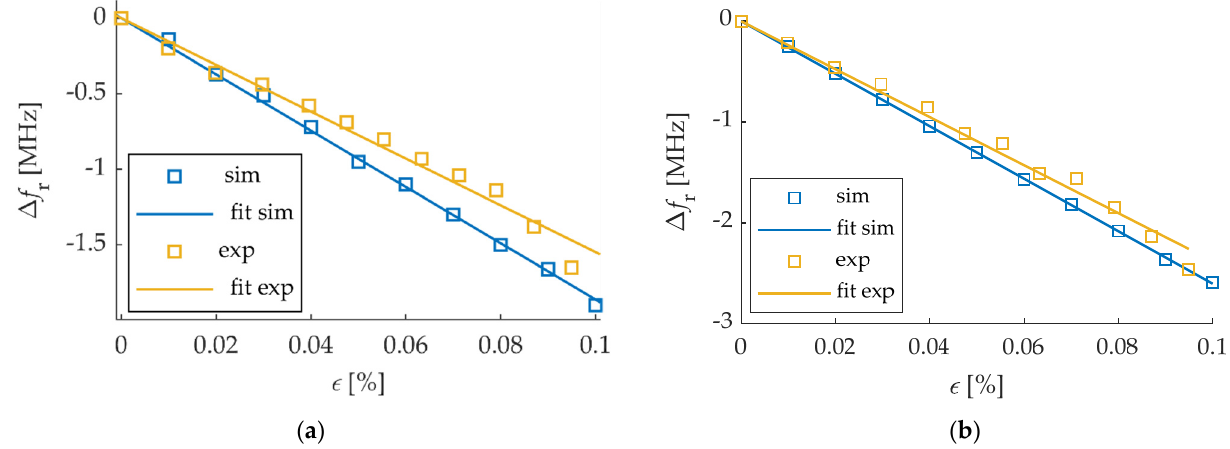
Figure 5. Influence of strain ε on shifts of resonant frequency Δ f r ( a ) dSRR microstrip sensor; ( b ) Rectangular microstrip sensor.